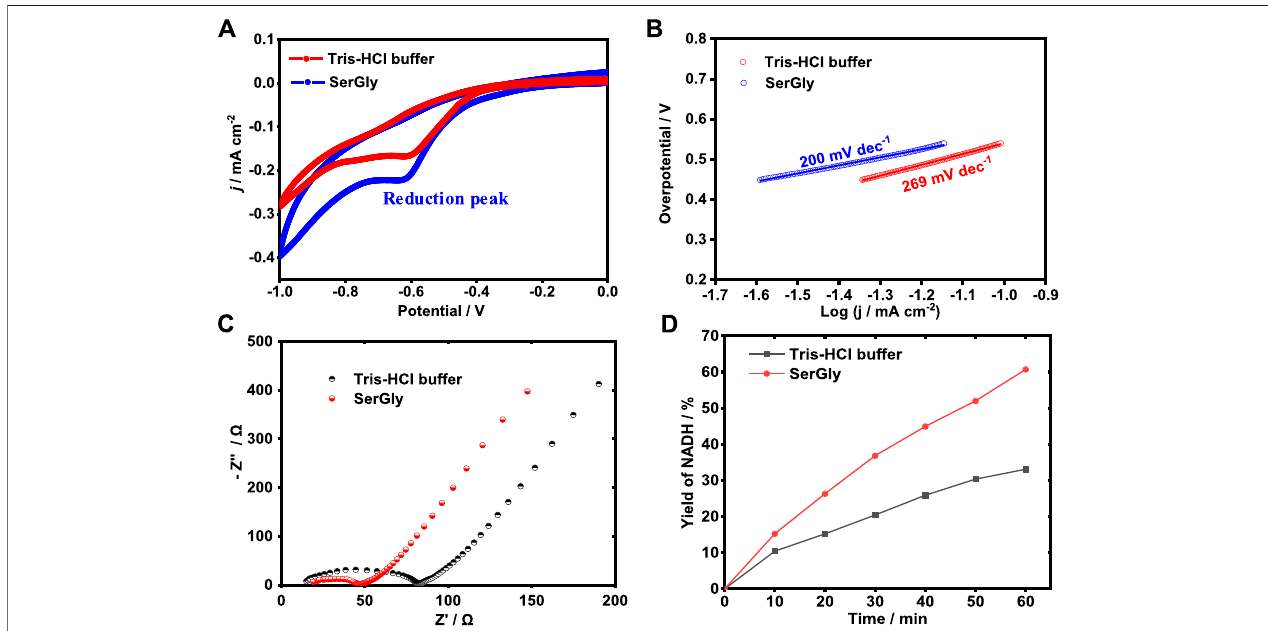
FIGURE 4 | (A) Cyclic voltammogram (CV) curves of electrocatalyst in the SerGly-contained buffer and Tris-HCl buffer. (B) Tafel plot of electrocatalysts in the SerGly-contained buffer and Tris-HCl buffer. (C) Nyquist plots for electrocatalyst in the SerGly-contained buffer and Tris-HCl buffer. (D) Electro-reduction of NAD+ to NADH in the SerGly-contained buffer and Tris-HCl